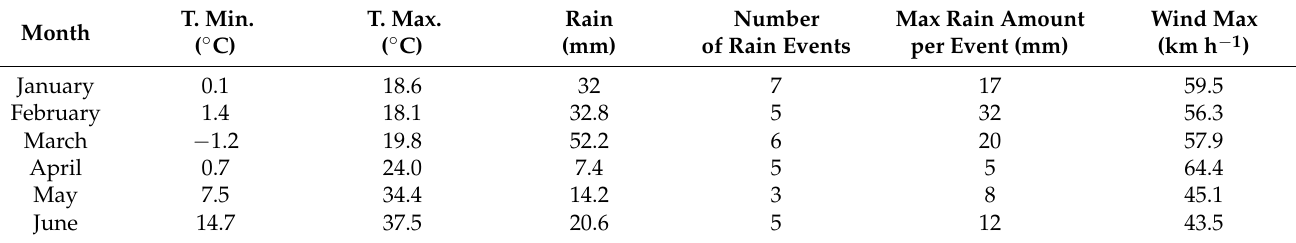
Table 2. Meteorological data, minimum and maximum temperature ( ◦ C), rain (mm), number of rain events, max rain amount per event (mm), and wind max (km h − 1 ) collected by the meteorological station in the field